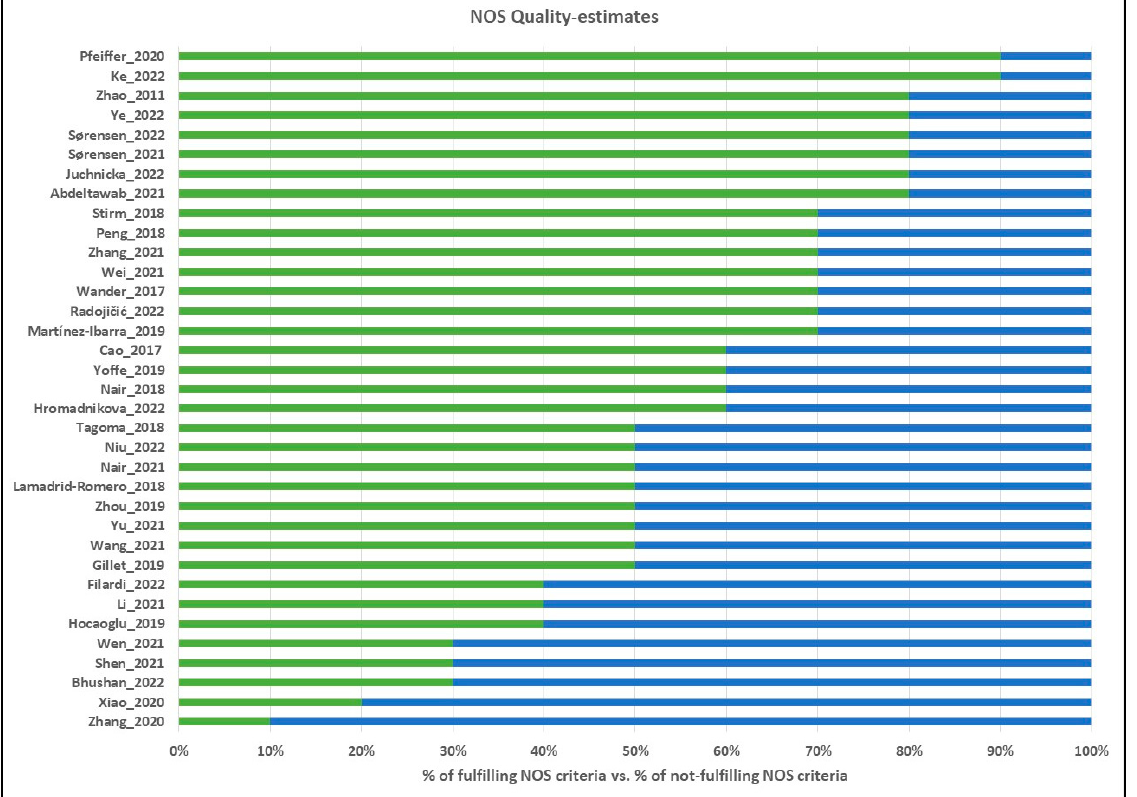
Figure 2. Quality evaluations of the included studies according to the NOS Scale. Green scale (right side) corresponds to the percentage of NOS scale points ful fi lled, and blue scale (left side) corresponds to the percentage of NOS scale points not ful fi lled. References for evaluated studies: